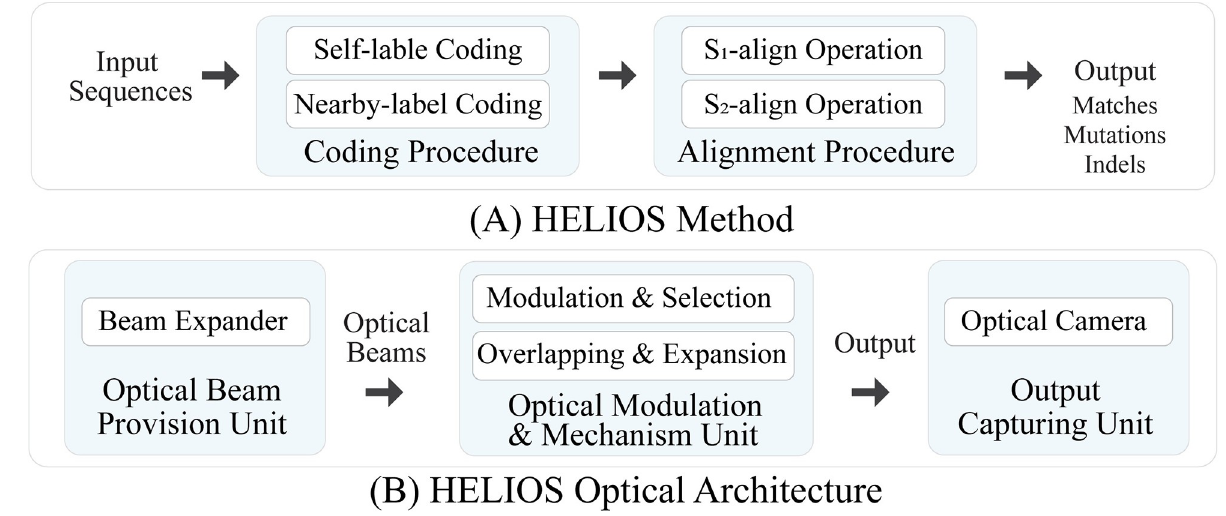
Fig 1. Block diagram illustration of the (A) HELIOS method and (B) HELIOS optical architecture. (A) the HELIOS method aligns two input sequences by performing the coding and alignment procedures to exactly locate character matches and variations; and (B) the HELIOS optical architecture executes the HELIOS method by performing the optical beam provision unit, the optical modulation and mechanism unit, and output capturing unit, utilizing inherent parallelism and high-speed processing in optics.